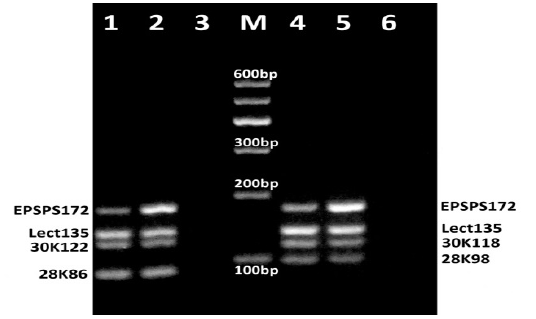
Figure 3. Fourplex PCRs for detection of GM Soybean allergens lectin, Gly m Bd 28K, Gly m Bd 30K and epsps using primer pairs lect135f/lect135r, 28K86f/28K86r, 30K122f/30K122r, ep- sps172f/epsps172r (N2) (lanes 1–3) and lect135f/lect135r, 28K98f/28K98r, 30K118f/30K118r, ep- sps172f/epsps172r (N1) (lanes 4–6). Samples: lanes 1, 4. CRM 1% RRS; lanes 2, 5. CRM 10% RRS, lanes 3, 6. water (negative control). M . Molecular weight marker (Qiagen GelPilot 100 bp ladder).